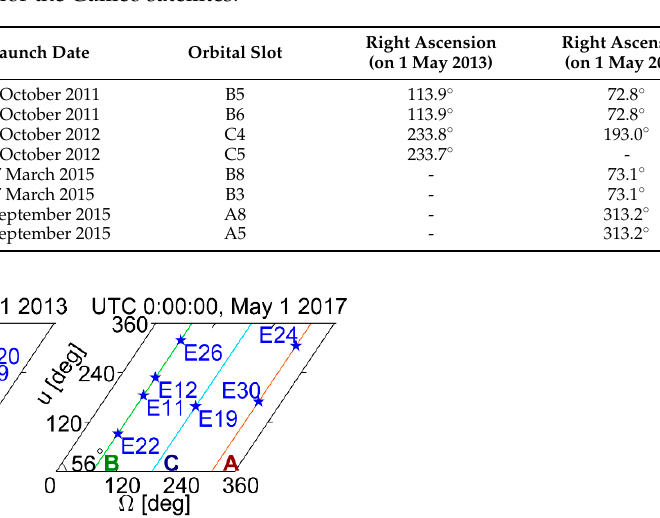
Table 1. Orbital elements for the Galileo satellites.